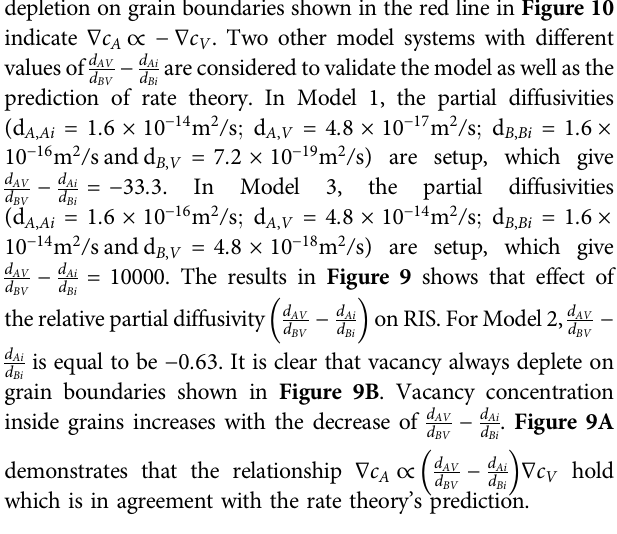
Frontiers in Materials |